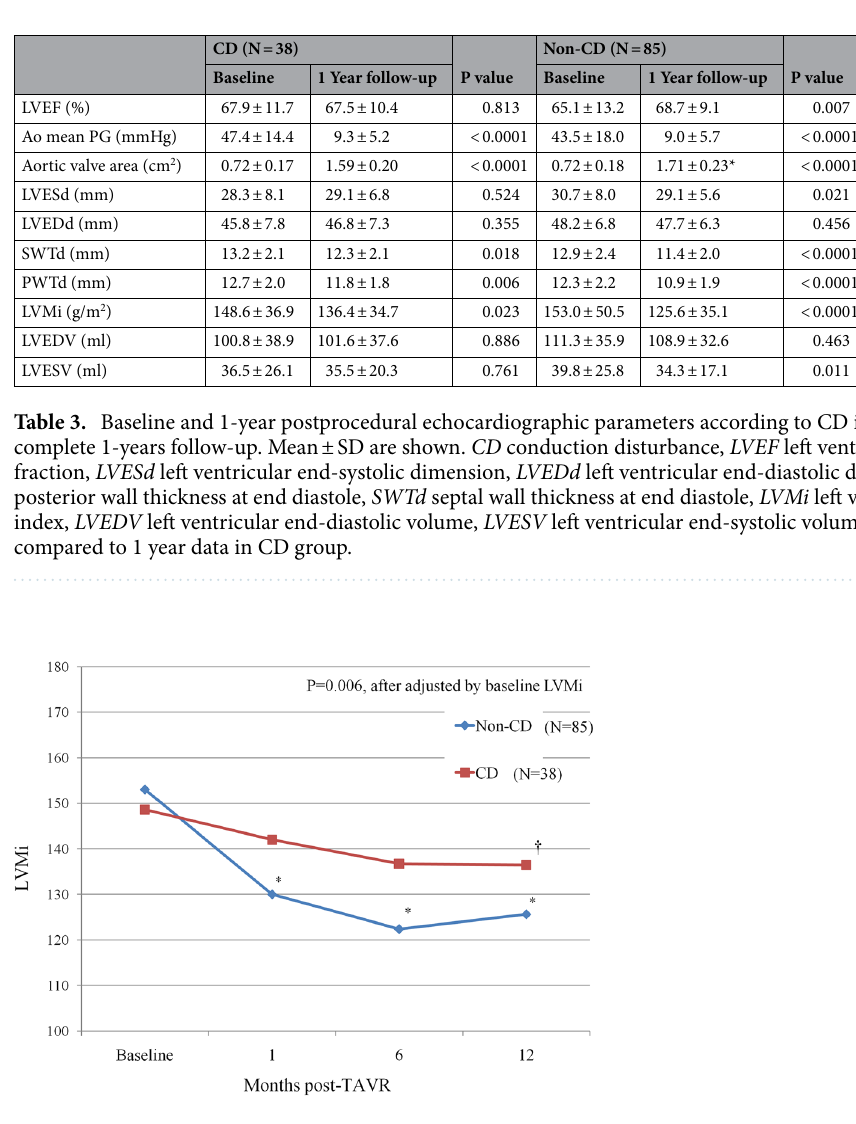
Figure 1. Temporal changes of LVMi before and after TAVR according to new onset of conduction disturbance in patients completing 1-year echocardiographic follow-up. CD conduction disturbance, LVMi left ventricular mass index, TAVR transcatheter aortic valve replacement. *P < 0.0001 as compared to baseline data. † P = 0.023 as compared to baseline